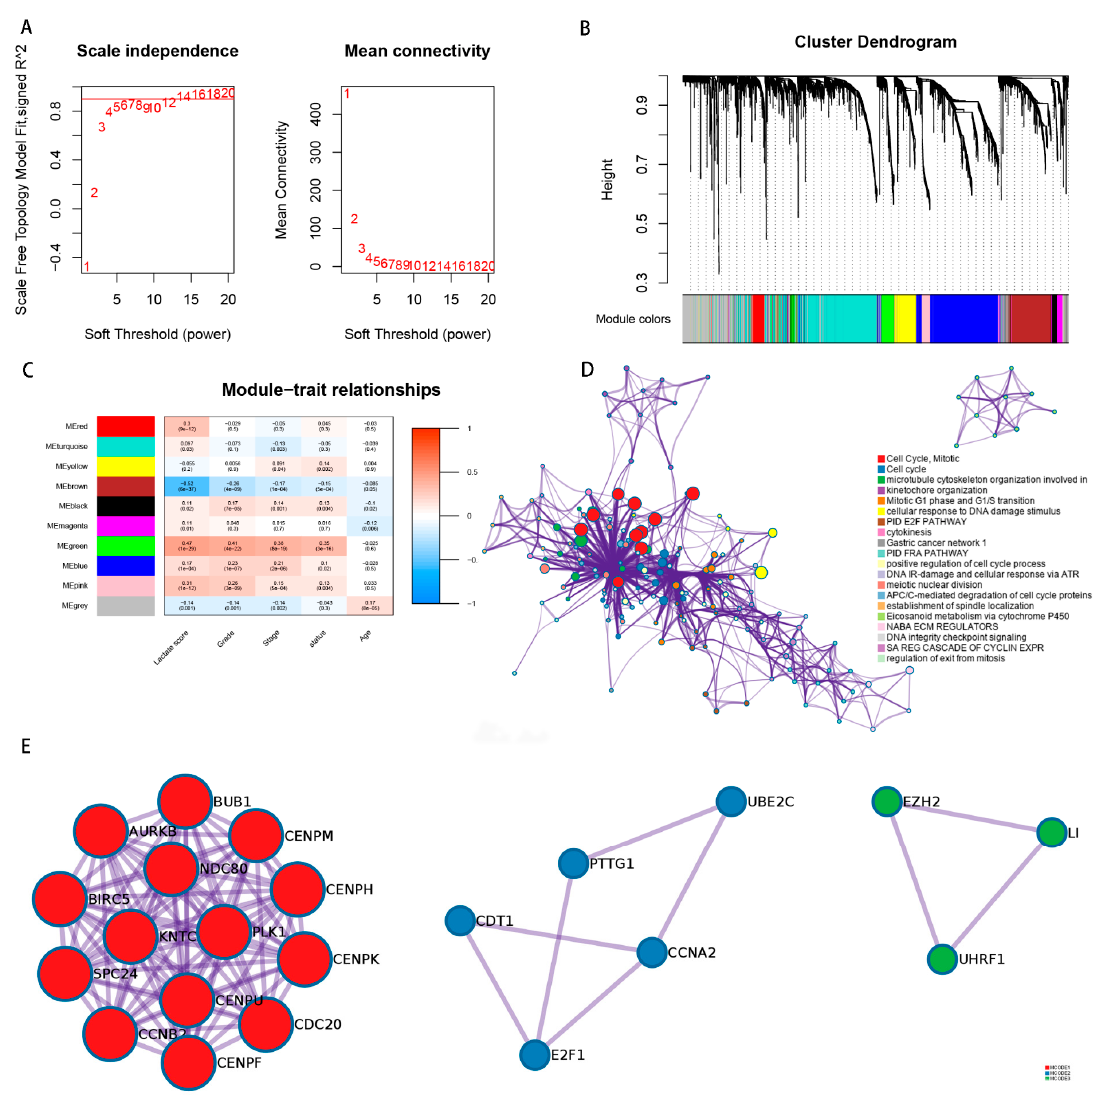
Figure 7. Gene weight co-expression network analysis and gene function enrichment analysis. ( A ) Soft power estimation in ccRCC for WGCNA. ( B ) Gene dendrogram with different colors showing the modules identified by WGCNA. ( C ) The relationship between gene modules and clinical characteristic. ( D ) Potentially enriched pathways of the co-expressed genes in green module. ( E ) The protein–protein interaction network of the top three signaling pathways.